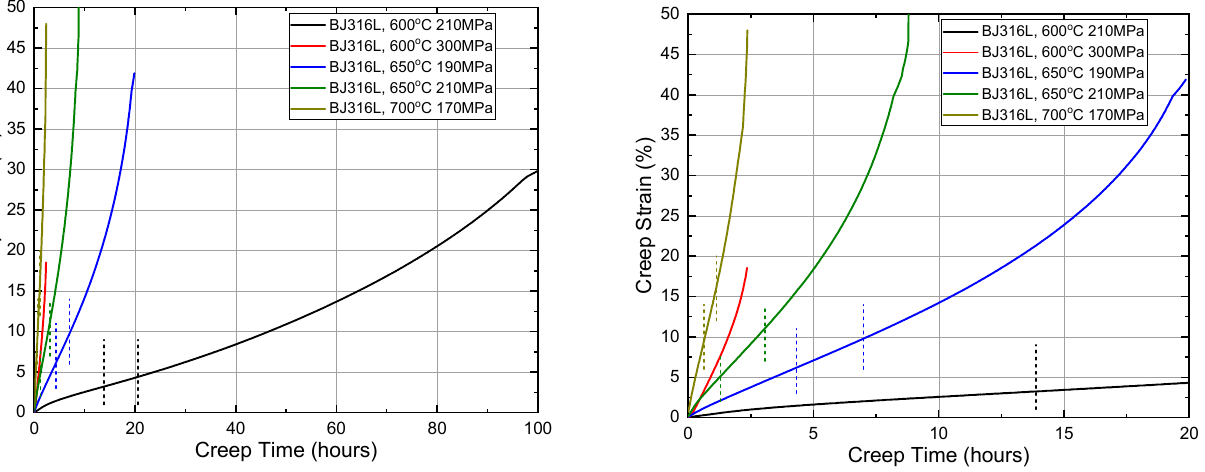
Figure 7. Creep curves for baseline Binder Jet 316L. Left: full creep curves. Right: enlarged view for the shorter tests. Two vertical dash lines on each curve (except 600 °C 300 MPa curve) indicate the transition from primary creep to secondary creep and the transition from secondary creep to tertiary